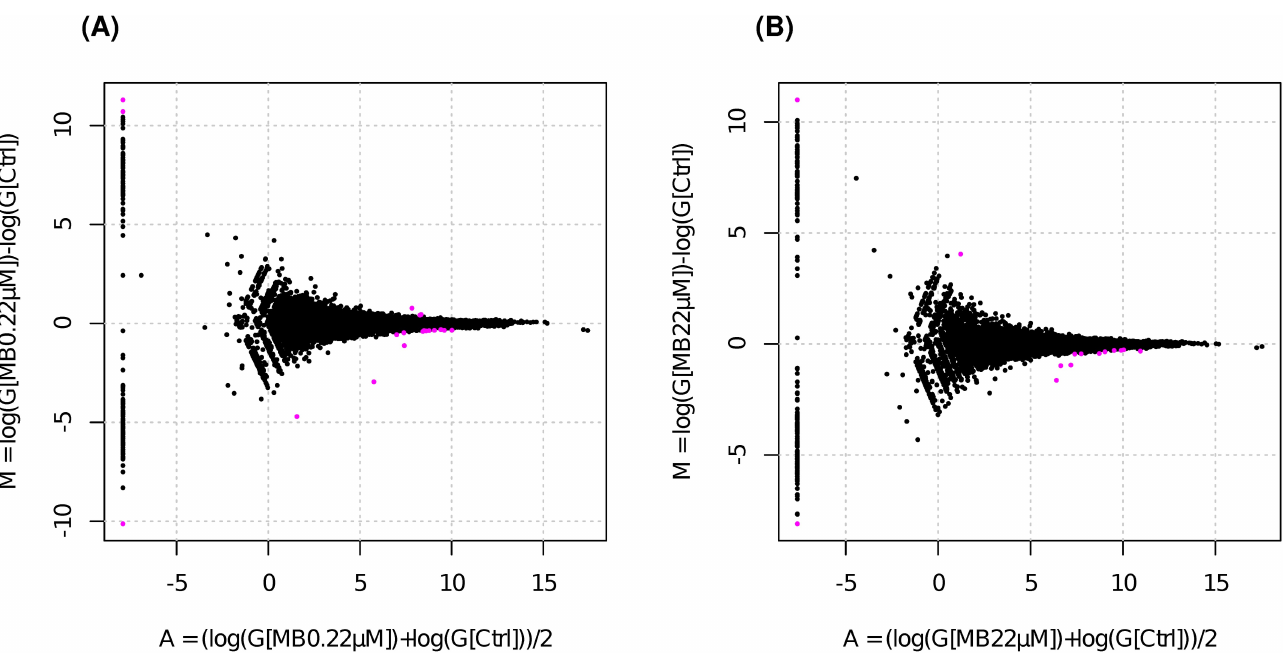
Fig 5. Mahafacyclin B alters the expression of a subset of genes in CHO-K1 cells. Genes marked in purplewere detected as differentially expressedat the 5% false-discovery rate (FDR) using TCC. (A) Scatter plot of differentiallyexpressedgenesin response to 0 or 0.22 μ M mahafacyclin B. (B) Scatter plot of differentially expressedgenesin responseto 0 or 22 μ M mahafacyclin B.